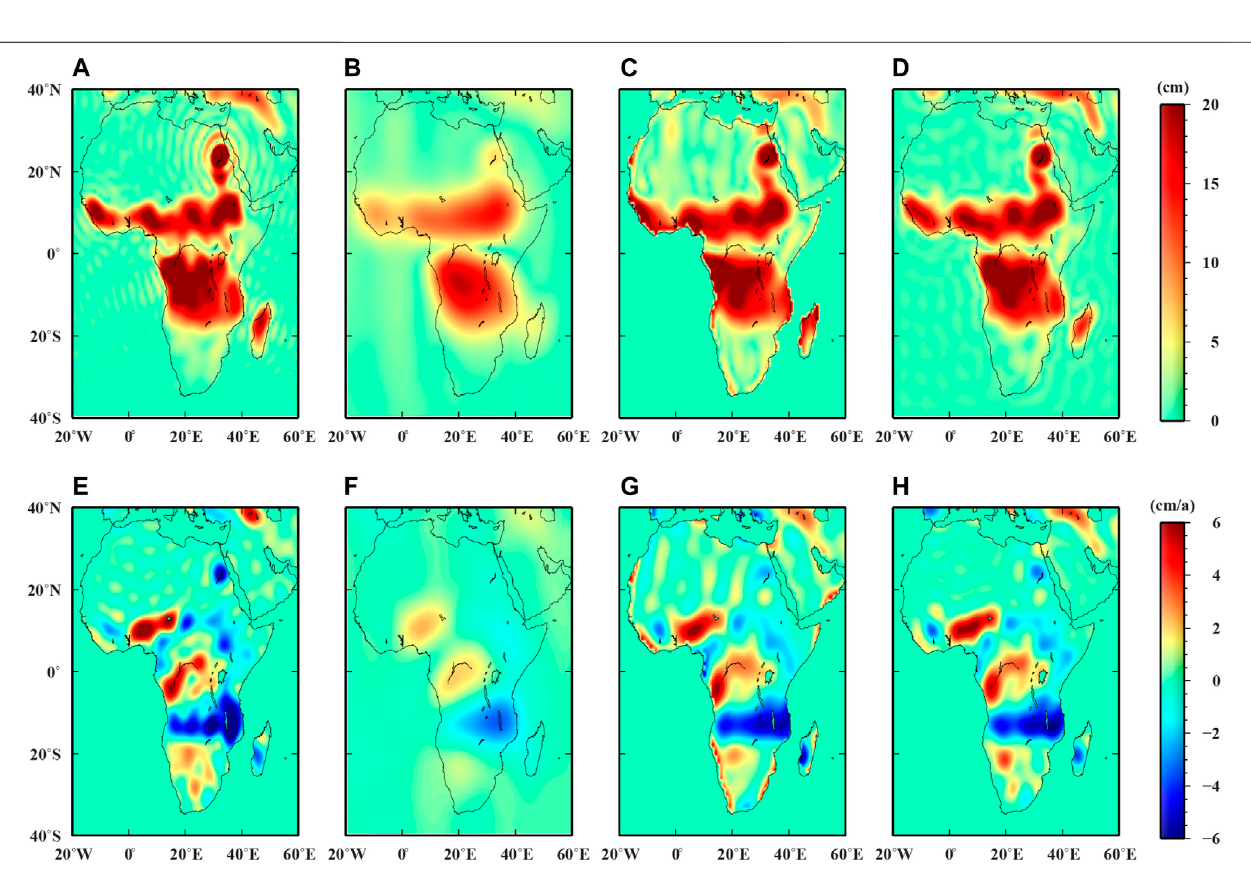
FIGURE 7 | Annual amplitudes and trends derived from different simulated solutions over Africa (A1) annual amplitudes of original ESM HIS model for comparison (B1) annual amplitudes of simulated GRACE data after 500 km Gaussian fi ltering (C1) annual amplitudes of simulated GRACE data after applying general forward- modeling method (D1) annual amplitudes of simulated GRACE data after applying improved forward-modeling method (A2) , (B2) , (C2) and (D2) show the trends derived from corresponding solutions.